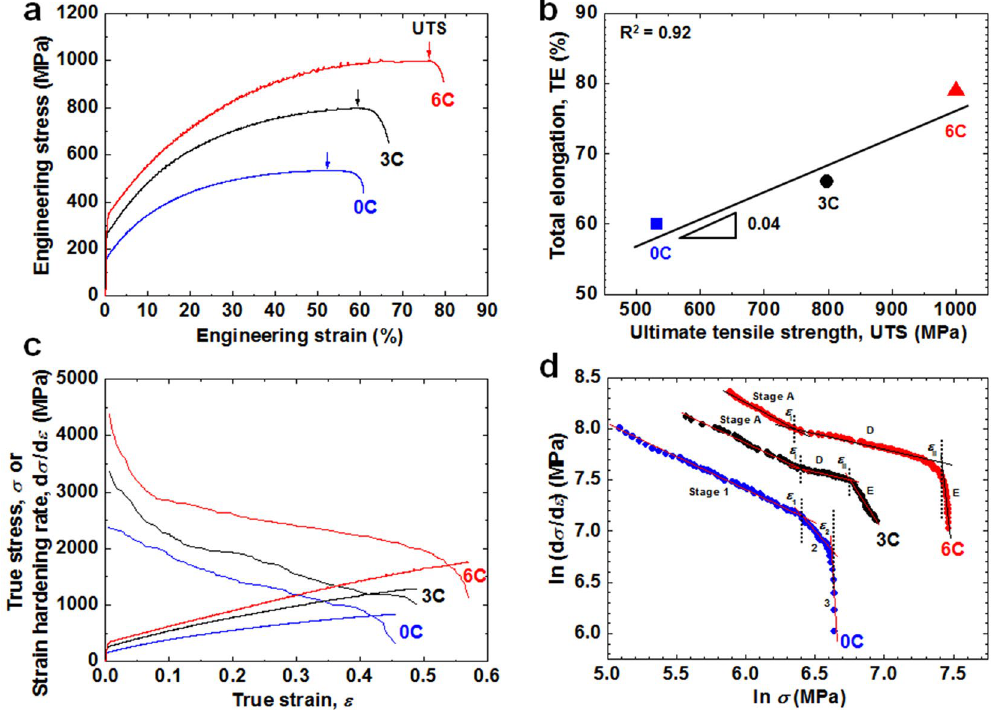
Figure 1. Tensile properties of Fe-high Mn steels (0C, 3C and 6C steels). ( a ) Engineering stress-strain curves, (b) total elongation (TE) vs . ultimate tensile strength (UTS) plot, (c) true stress-strain ( σ − ε ) and strain- hardening rate (SHR, d σ /d ε ) curves and (d) ln (d σ /d ε ) - ln σ plots. All tensile tests were performed at room temperature with an initial strain rate of 1 × 10 − 4 s − 1